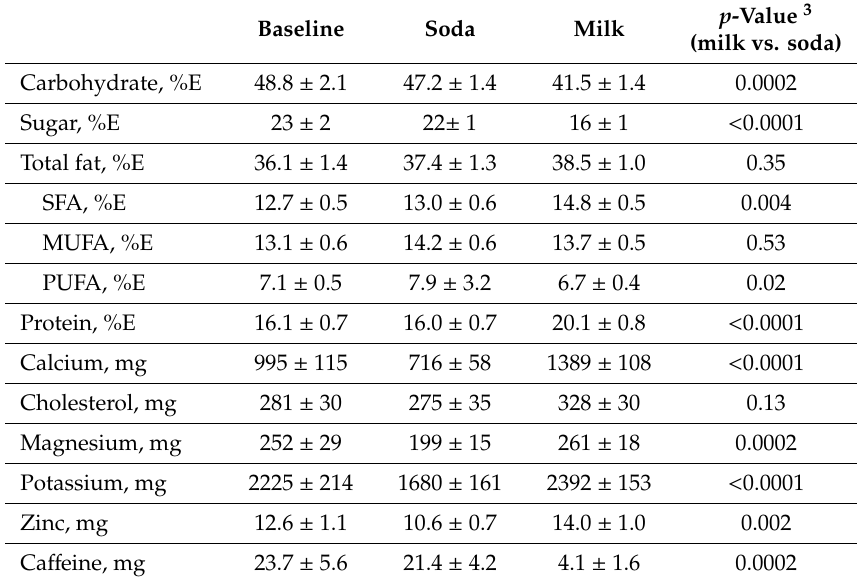
Table 2. Nutrient intake assessed by 24-h recall surveys 1,2